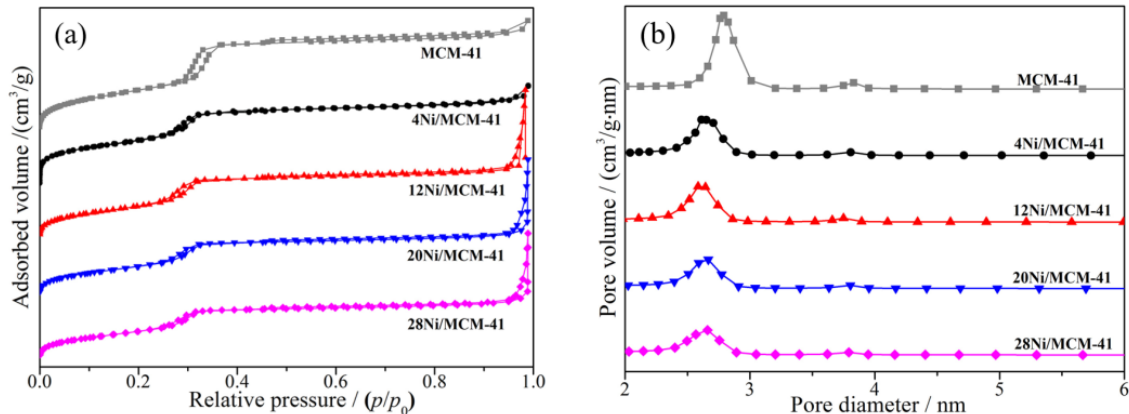
Figure 5. ( a ) Pore size distributions and ( b ) N 2 adsorption-desorption isotherms of MCM-41 support and reduced x Ni/MCM-41 catalysts.